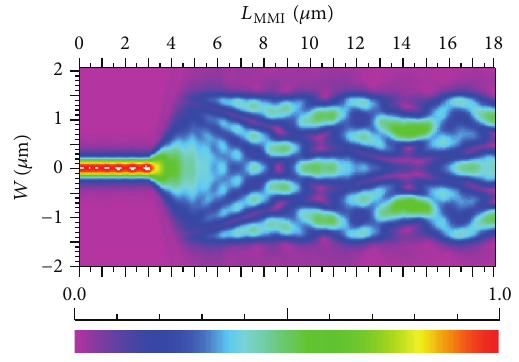
Figure 3: Optical field distribution of an MMI.